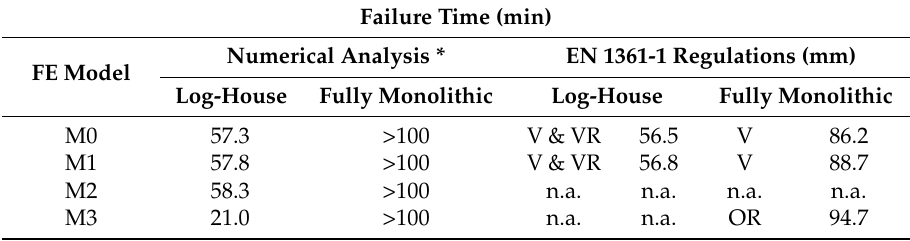
Table 4. Numerical estimation of the fire resistance of the W80 assembly, for different thermal insulation configurations and mechanical interaction between the timber